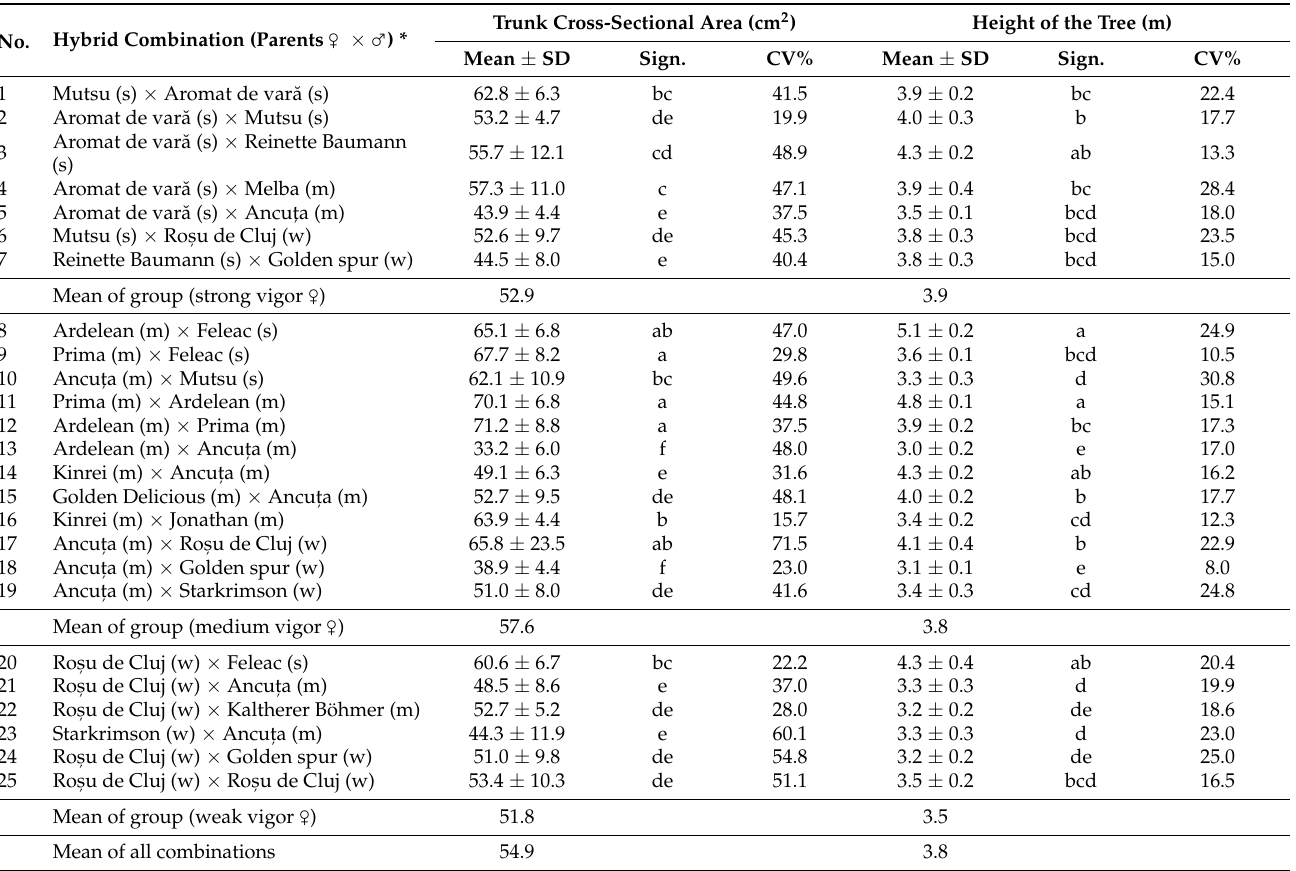
Table 1. Trunk cross-sectional area (cm 2 ) and tree height (m) in F 1 apple hybrids in different hy- brid